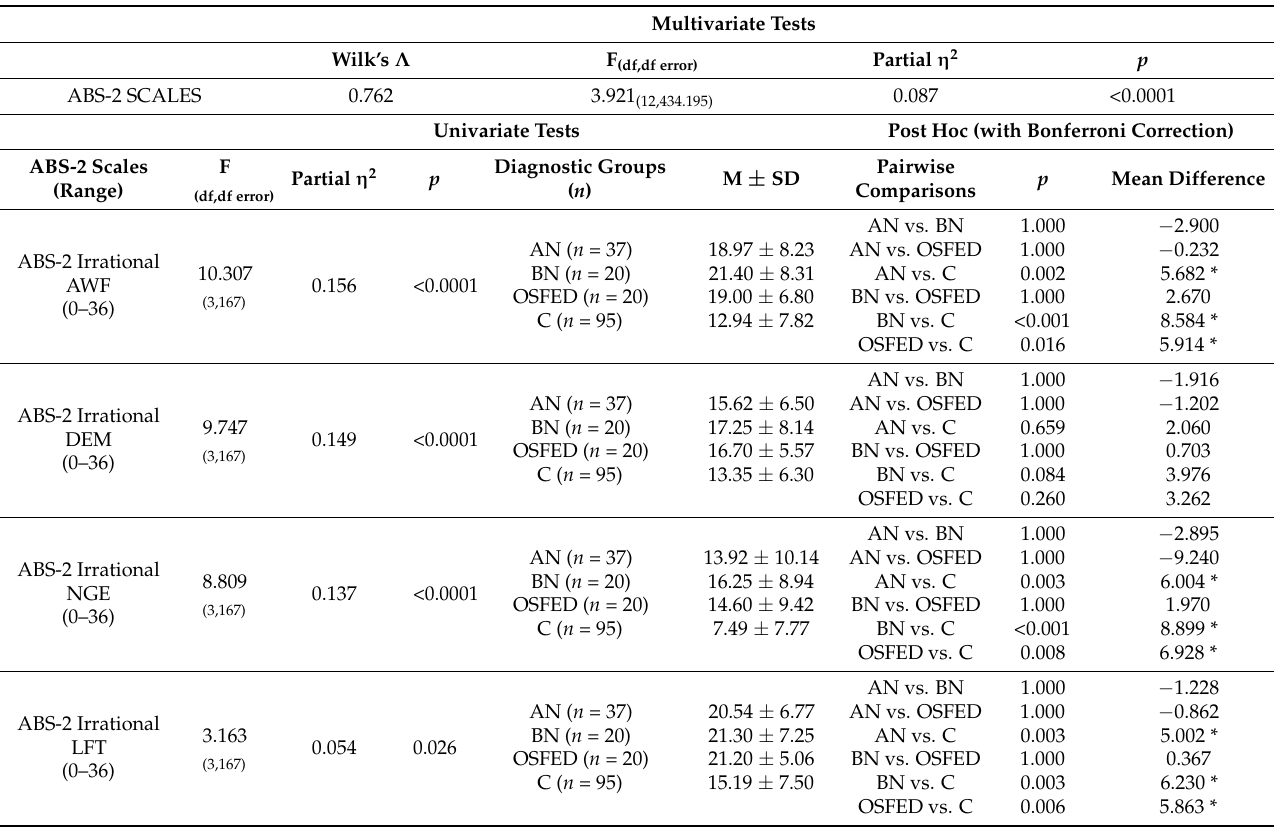
Table 1. MANOVA and post hoc tests with Bonferroni correction comparing ED patients and controls in types of irrational beliefs